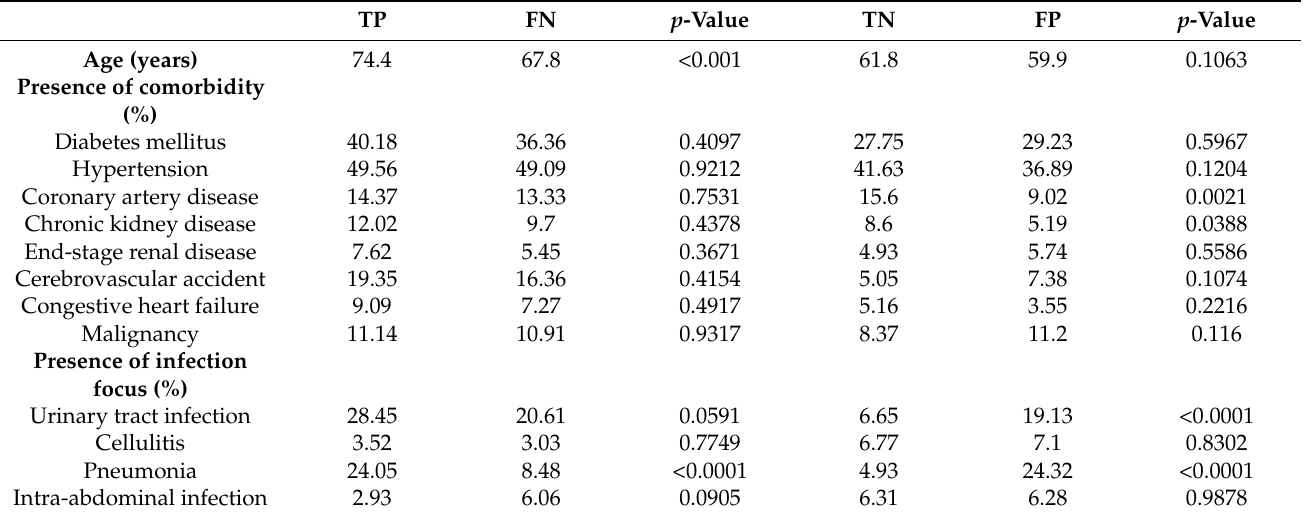
Table 4. Statistical analysis of comorbidities and infection source among patients in the external validation dataset, divided according to the model